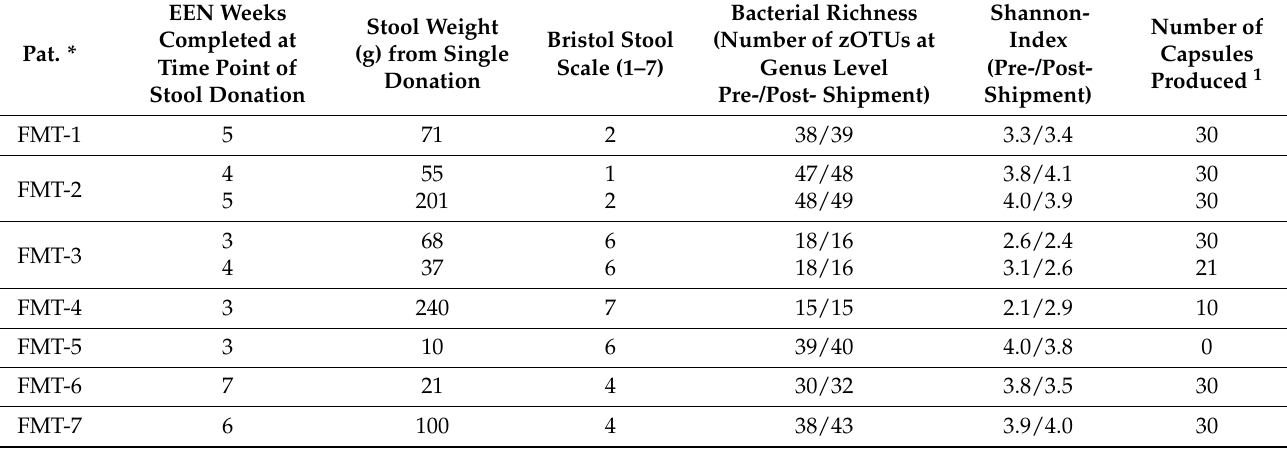
Table 2. Test runs of FMT capsule production for potential autologous